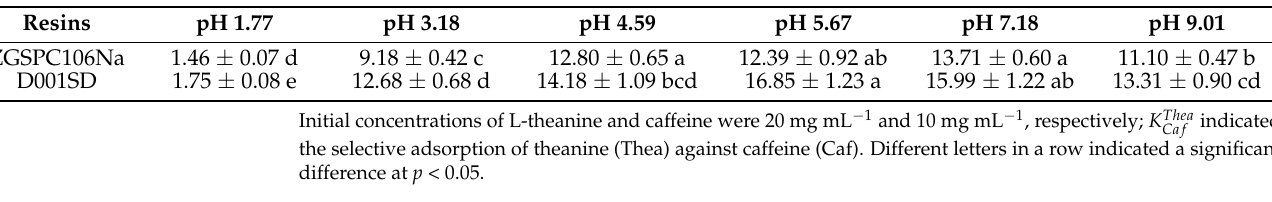
Table 2. Selectivity coefficient K Thea